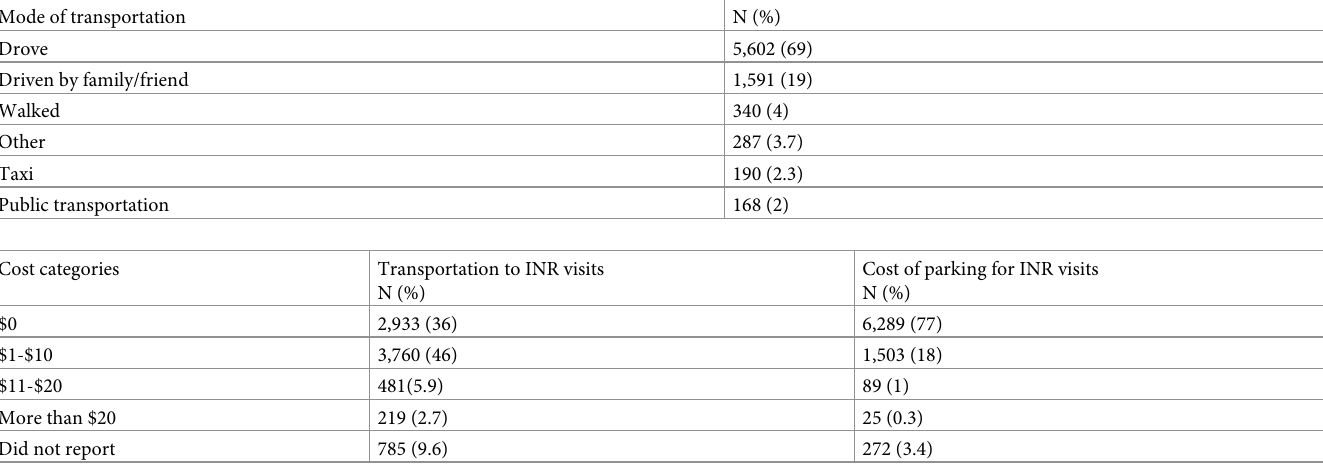
Table 2. a. Transportation modes used by study participants when travelling for INR testing visits (n = 8,178 visits). b. Direct costs of transportation and parking for INR testing visits during study follow-up period (n = 8,178 visits). Mode of transportation N